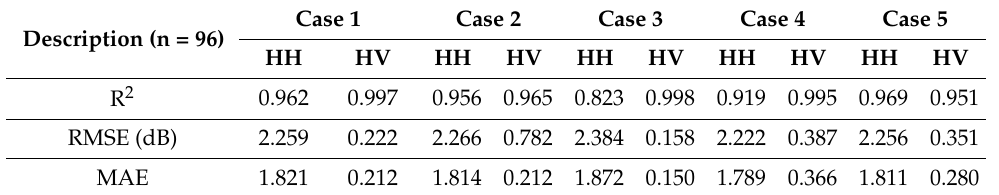
Table 5. Metrics comparison between observed and simulated backscatter coefficients from WCM for HH and HV polarization with respect to the vegetation